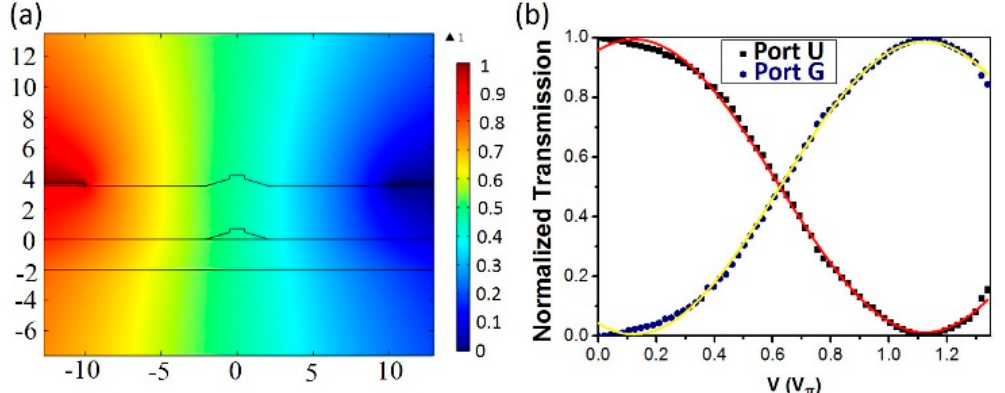
Figure 5. ( a ) Calculated normalized electric-field distribution in cross-sectional plane of LNOI waveguide when applying voltage on Au microelectrodes, showing that the electric field was almost parallel to the LN optic axis. ( b ) Normalized transmission spectra of output Ports U and G as a function of applied voltage V, featuring sinusoidal-like curve.